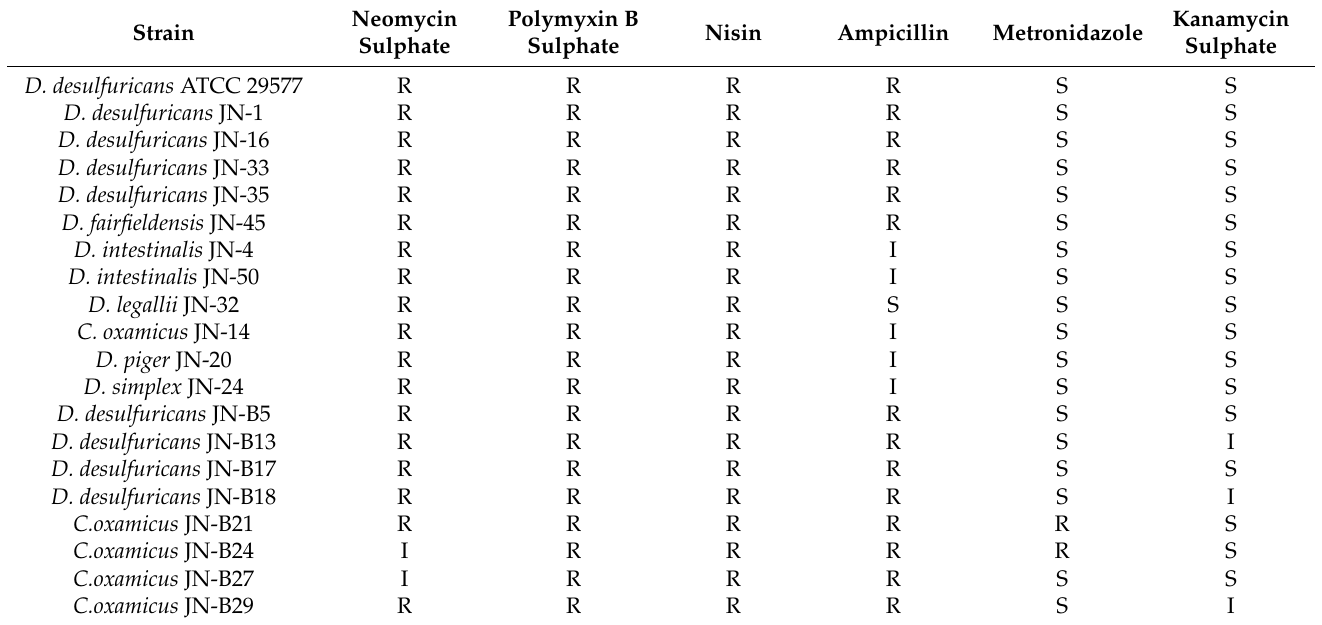
Table 1. Sensitivity of Desulfovibrio from the human gut to different antibiotics. S—Susceptible, Stan-